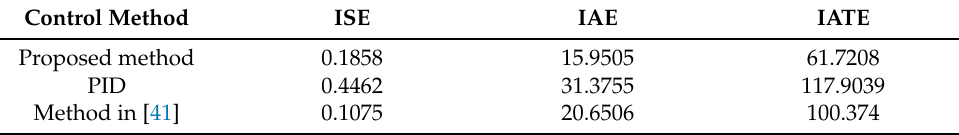
Figure 9. Tracking performance and tracking error (Noted that Lu et al. (2019) represents the reference [41]). Table 3. Tracking error performance indices by using proposed method, PID and method presented in